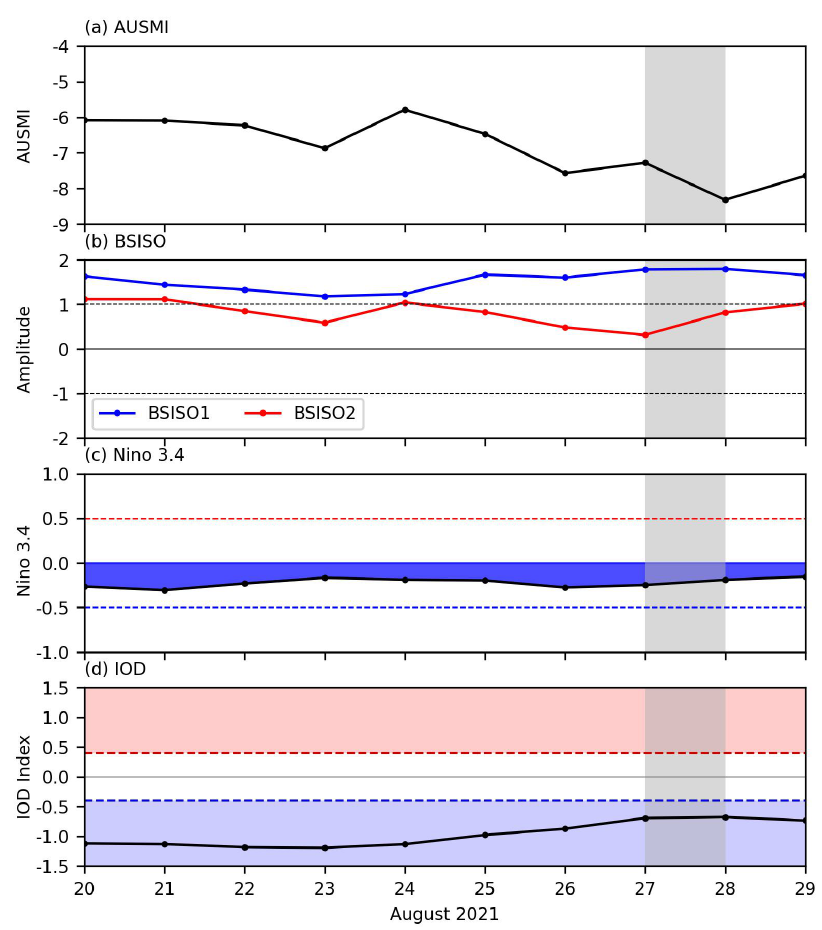
Figure 10. Daily time series of climate mode indices during 20–29 August 2021 for ( a ) AUSMI, ( b ) BSISO, ( c ) Nino 3.4, and ( d ) IOD. The grey color shows the flood event over Nusantara on